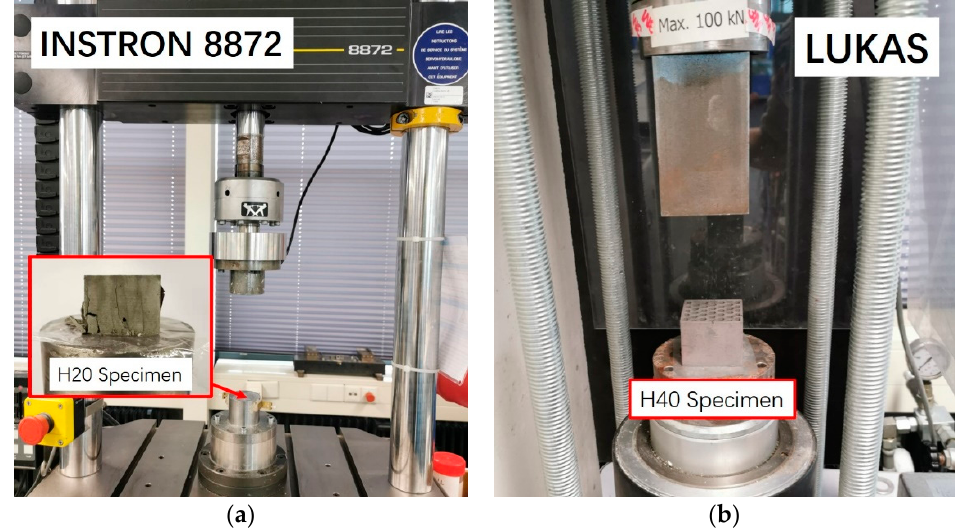
Figure 7. Two different hydraulic press machines, ( a ) INSTRON 8872 for H20 and ( b ) LUKAS for H40. Table 2. Specimen